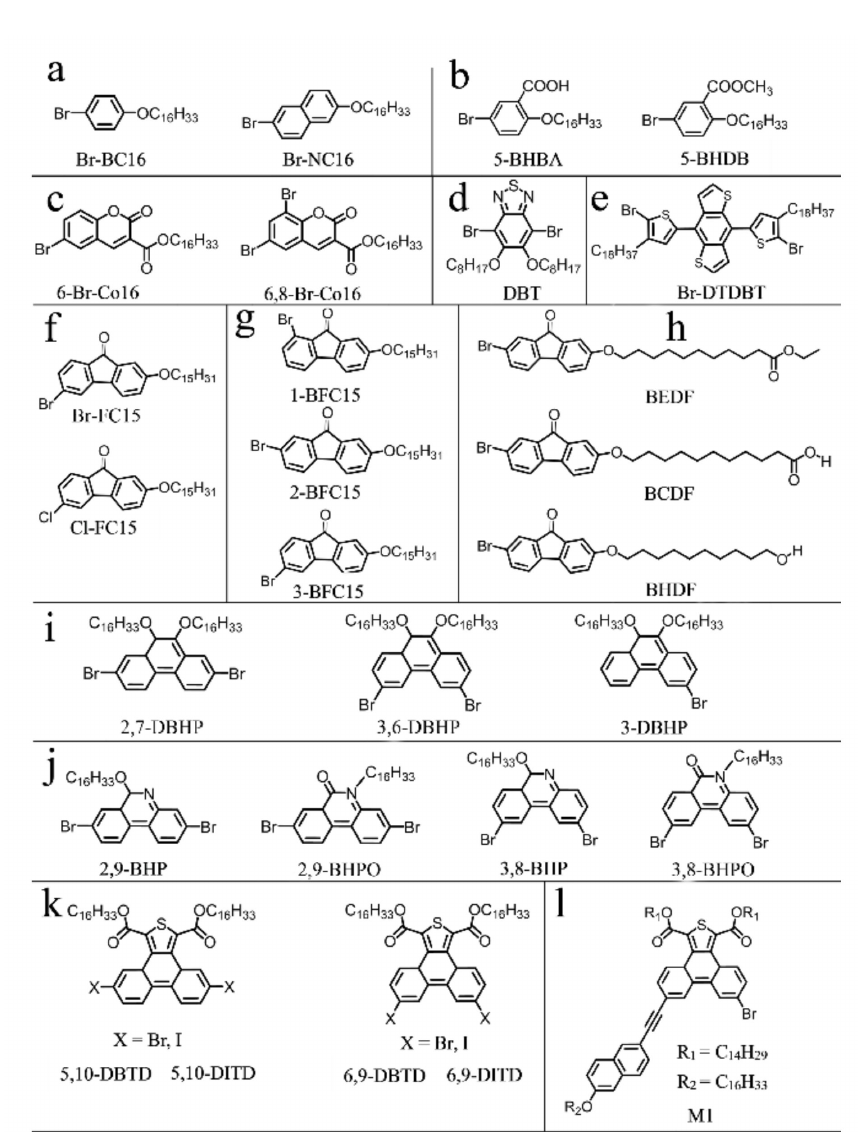
Scheme 1. Chemical structures of the halogenated molecules. ( a ) Molecules with different geometry symmetries of π -conjugated cores along C − Br bond (Br-BC16 and Br-NC16). ( b ) Bifunctional benzene derivatives (5-BHBA and 5-BHDB). ( c ) Bromine substituted coumarin derivatives (6-Br-Co16 and 6,8-Br-Co16). ( d ) Thiadiazole derivative (DBT). ( e ) Dithiophene derivative (Br-BTDBT). ( f ) Different halogen substituted (Br, Cl, and F) fluorenone derivatives (Br-FC15, Cl-FC15, and F-FC15). ( g ) Fluorenone derivatives with different positions of Br substituents (1-BFC15, 2-BFC15, and 3-BFC15). ( h ) Fluorenone derivatives with different terminal groups (BEDF, BCDF, and BHDF). ( i ) Phenanthrene derivatives with different numbers and positions of halogen substituents on the π -conjugated cores (2,7-DBHP, 3,6-DBHP, and 3 − DBHP). ( j ) Four regioisomeric phenanthridine derivatives with different positions of halogen substituents and alkoxy chains (2,9-BHP, 2,9-BHPO, 3,8-BHP, and 3,8-BHPO). ( k ) Thienophenanthrene derivatives with different positions of halogen substituents on the π -conjugated cores (6,9-DBTD and 5,10-DBTD). ( l ) An asymmetric thienophenanthrene derivative (M1). All the 28 molecules are used to investigate the 2D supramolecular self-assembled nanostructures based on XBs in our